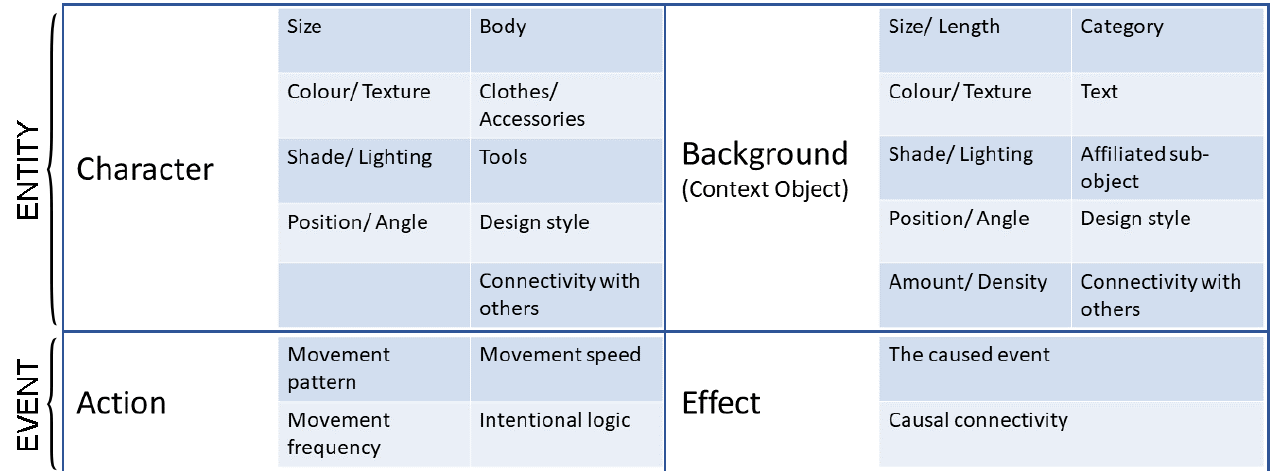
Figure 5. Visual channels within the story environment.